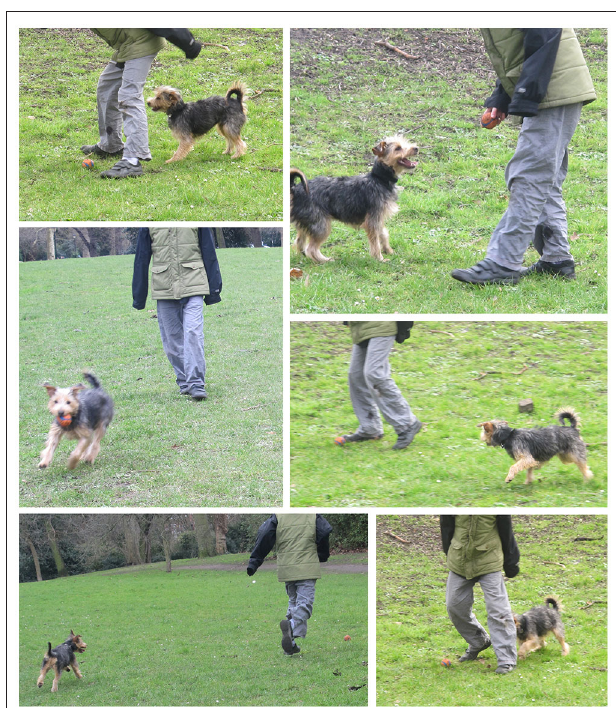
FIGURE 8 | Terrier playing ball with human, London, UK.